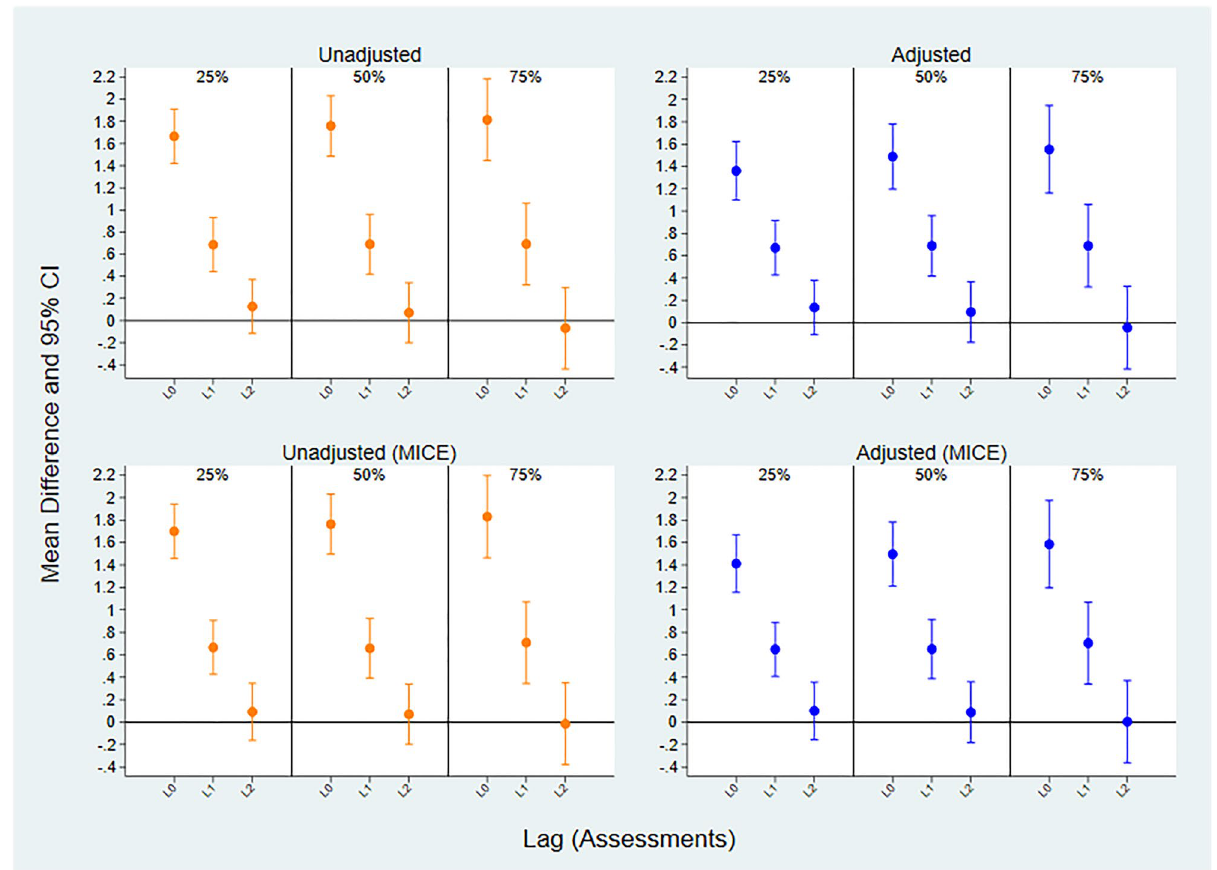
Figure 2. Time-lagged associations of momentary mental wellbeing scores in relation to seeing or hearing birds. Associations are shown unadjusted and adjusted for age, gender, education, occupational status, ethnicity, whether participants could see trees, plants, and see or hear water, and with the implementation of the MICE procedure. The vertical axis represents the mean difference (MD) and 95% confidence intervals (95% CI) of mental wellbeing score when seeing or hearing birds. The horizontal axis represents the assessments lagged from 0 to 2. L0 indicates the impact of seeing or hearing birds on mental wellbeing at the time of the assessment. L1 indicates the impact of seeing or hearing birds on mental wellbeing during the subsequent assessment. L2 indicates the impact of seeing or hearing birds on mental wellbeing in the second subsequent